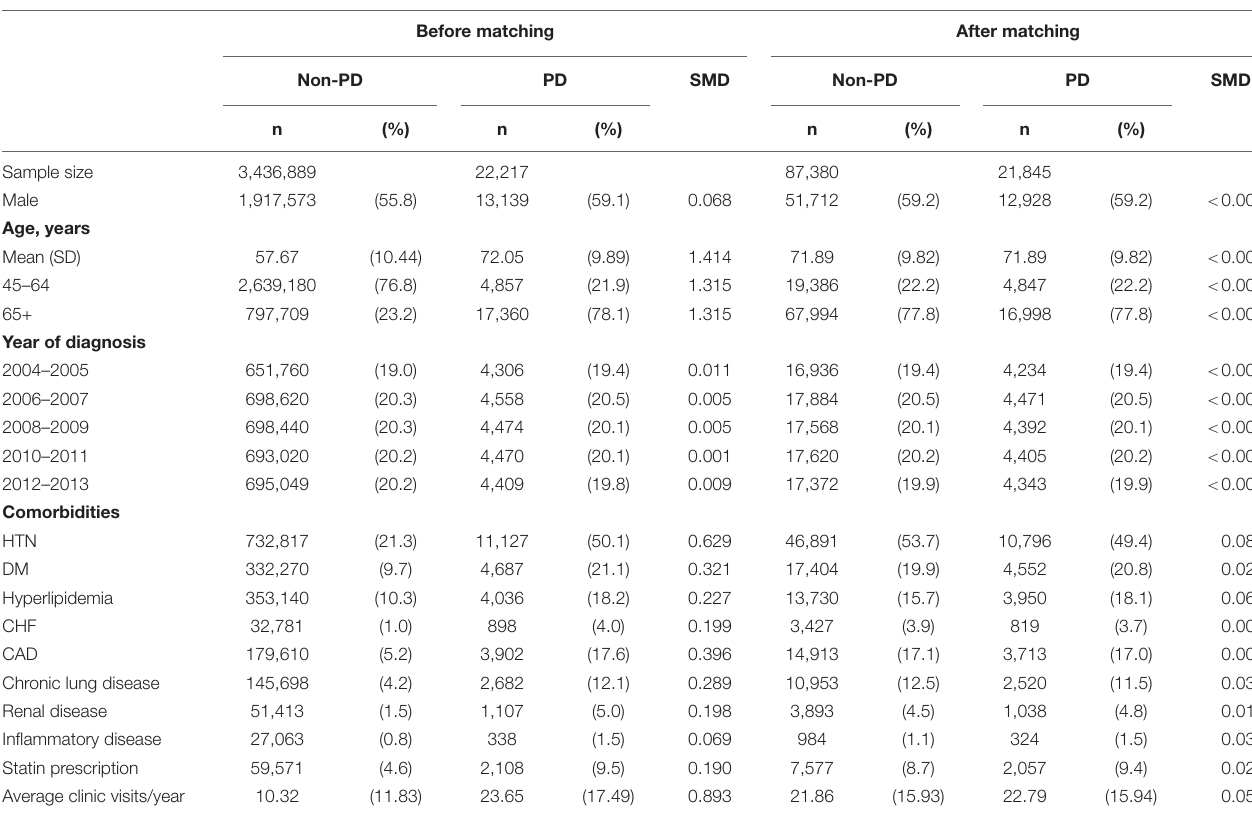
TABLE 1 | Baseline characteristics of participants with PD versus non-PD before and after PSM. Before matching